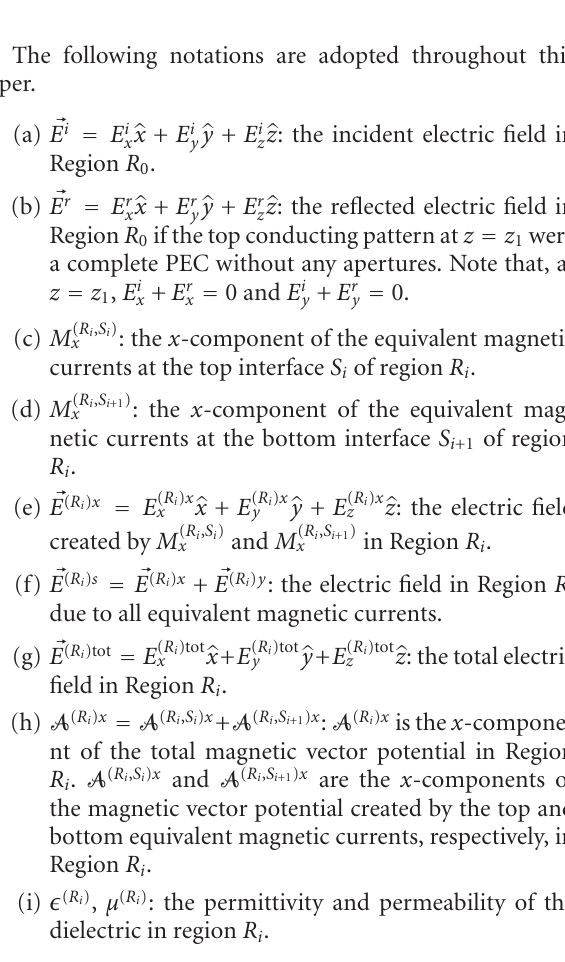
Figure 1: Cross-section of a generic multilayer 2D periodic struc-